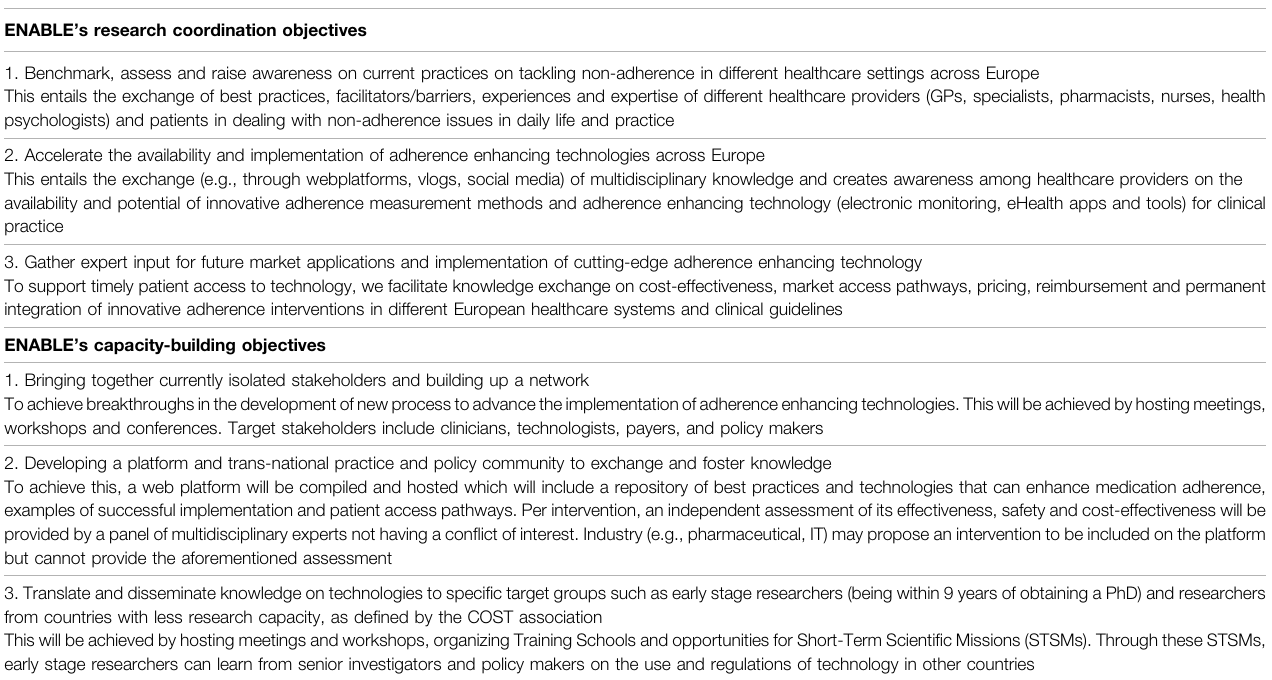
TABLE 1 | ENABLE ’ s research coordination and capacity building